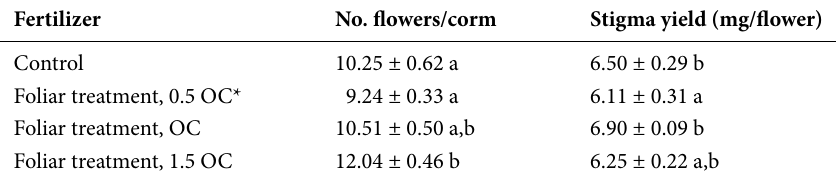
Table 3 Effect of foliar fertilizers on number of flowers per corm and stigma yield.